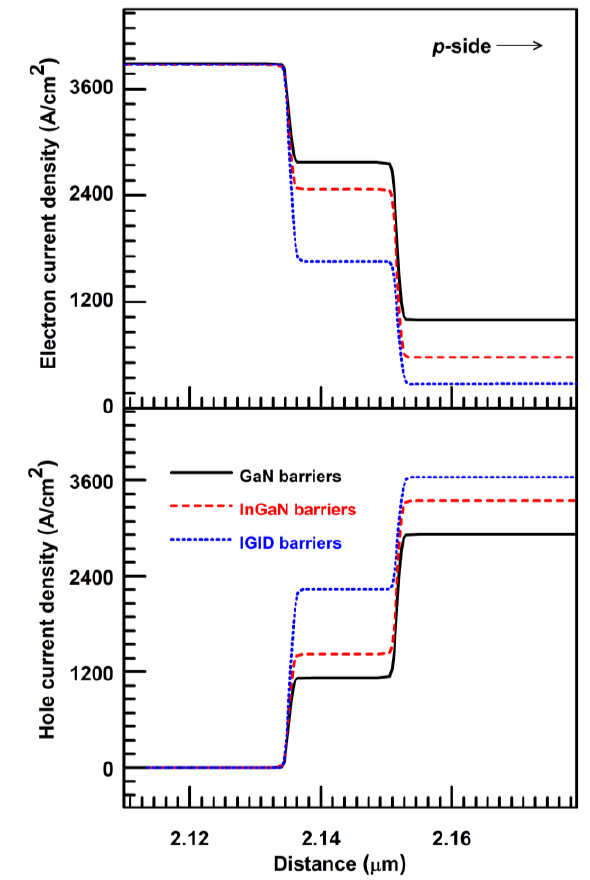
Figure 5. The electron and hole current density distributions in the LDs with ( a ) GaN, ( b ) InGaN, and ( c ) IGID barriers at 120 mA.